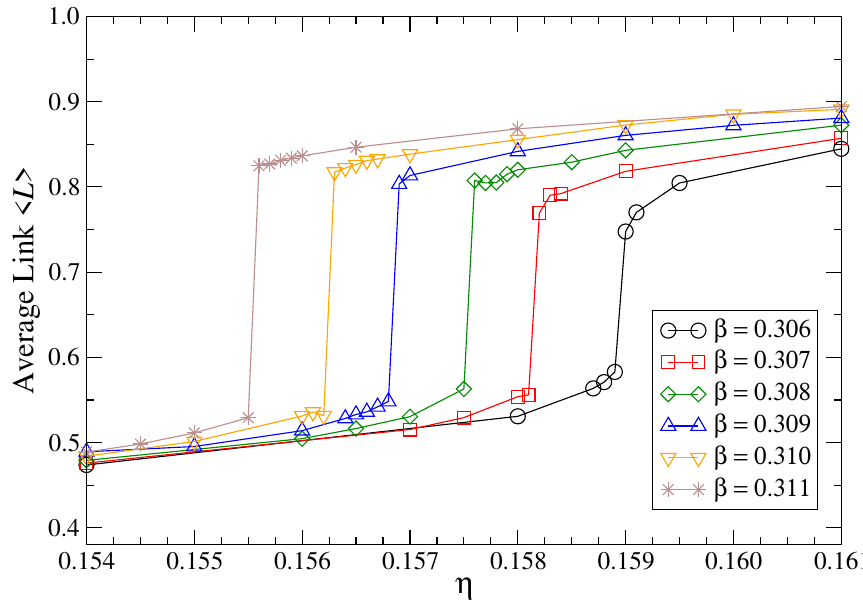
Figure 10 . η dependence of h L i at µ = 1 for β ∈ [0 . 306 , 0 . 311] .